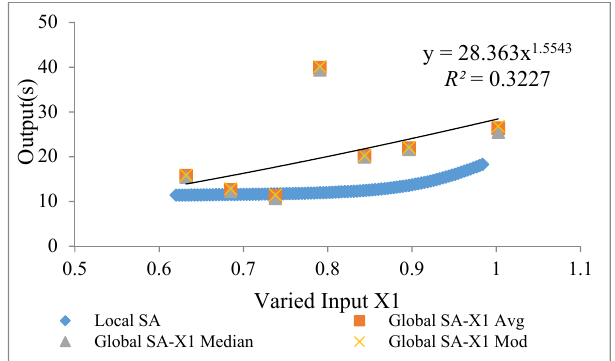
Figure 8. Network output (HL) for varied relative compactness (X1).